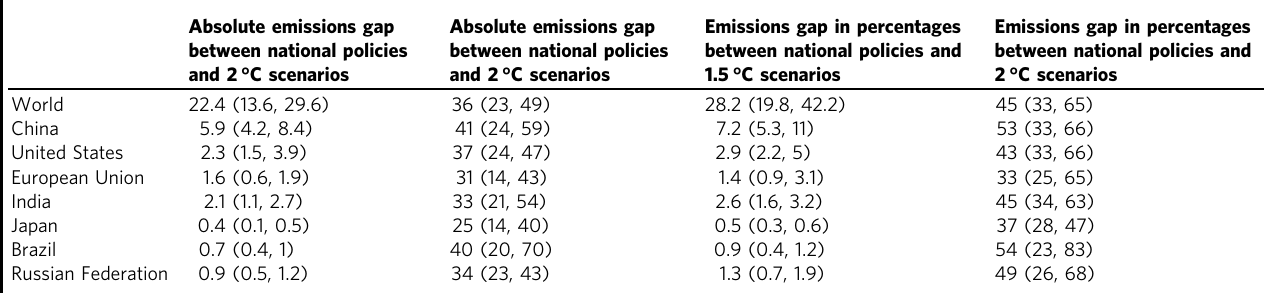
Table 3 Absolute (GtCO 2 eq) and percentage emissions gaps by 2030, on the global level and for China, the United States, the European Union, India, Japan, the Russian Federation and